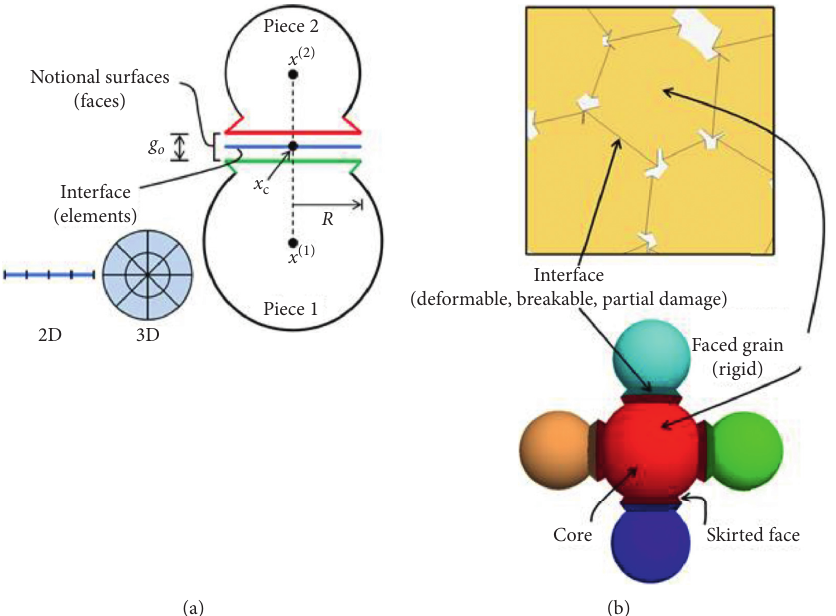
Figure 17: Flat-joint contact (left) (a) and flat-jointed material (right) (b)